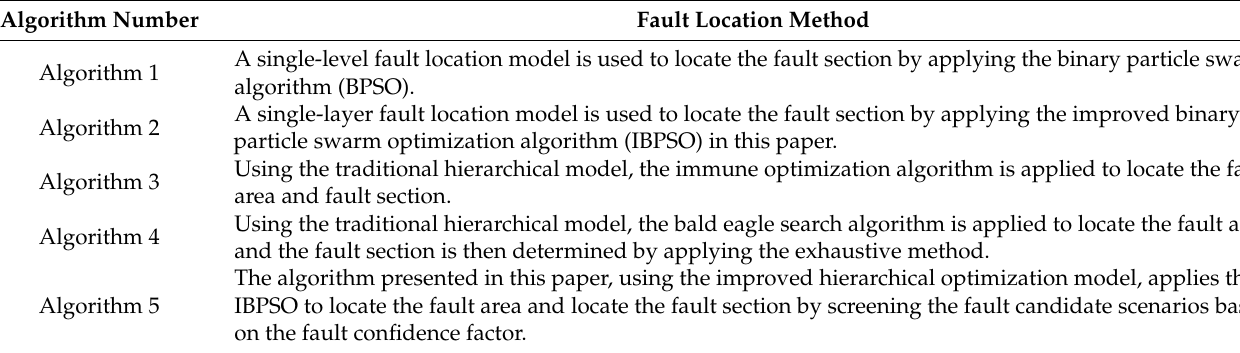
Table 4. Fault location methods for various